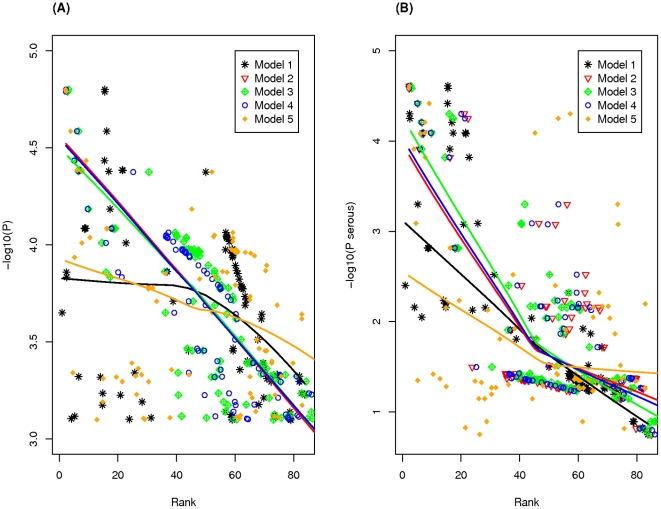
Plot of SNP ranks (mean of posterior distribution of rank) and the −log10(p-values) from analyses using (A) all invasive cases or (B) only invasive serous cases for each of the five BLVMs.